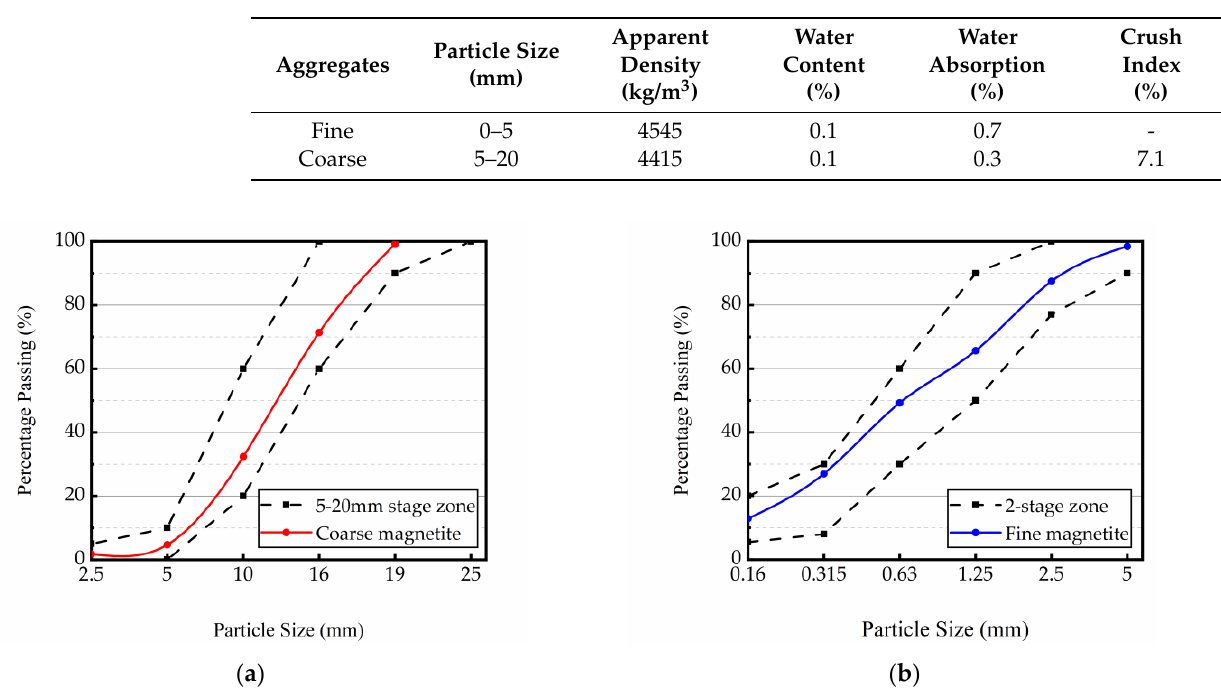
Figure 1. ( a ) Grading curve of magnetite coarse aggregates; ( b ) Grading curve of magnetite fine aggregates. Table 2. Basic performance of magnetite aggregate.